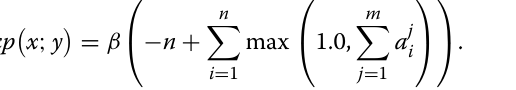
Table 2 The new Arabic dataset, AHS, statistics